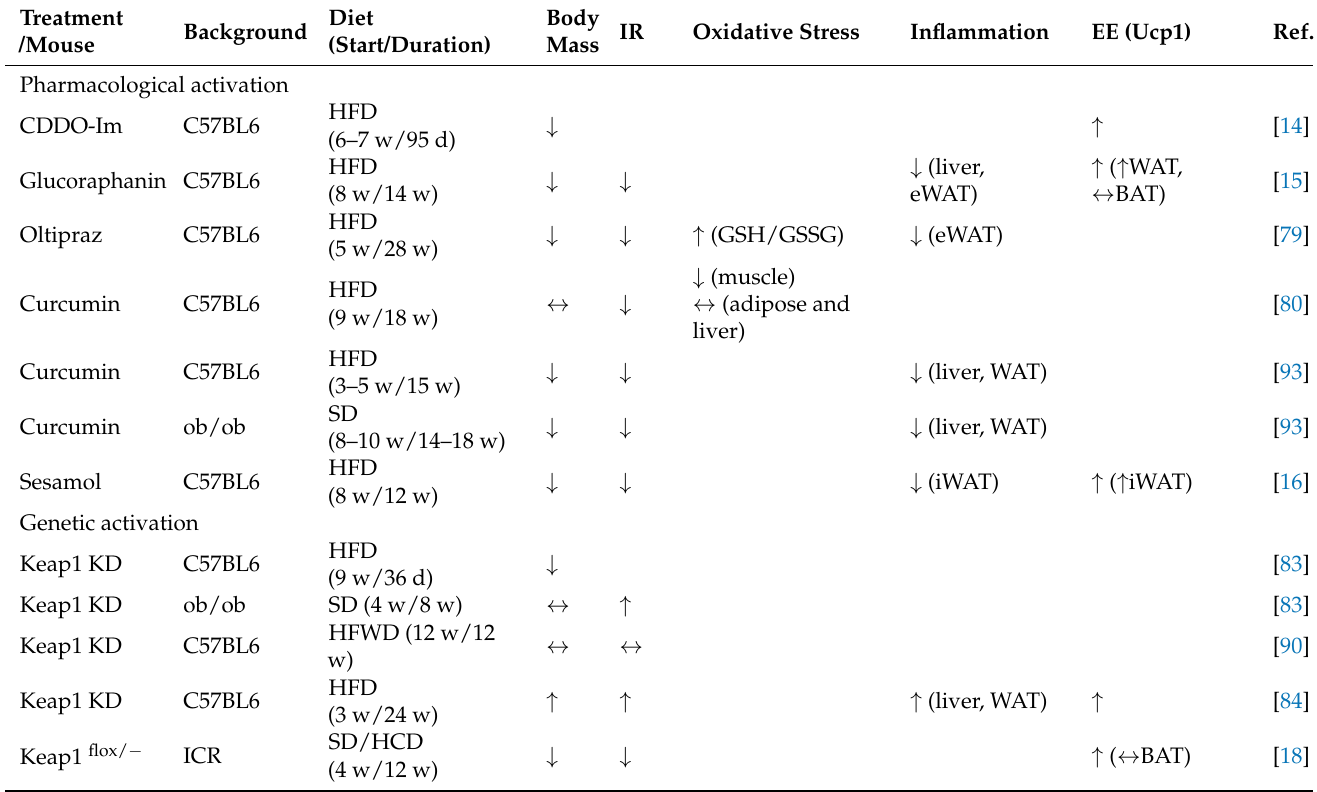
Table 2. The effects of Nrf2 activators in energy